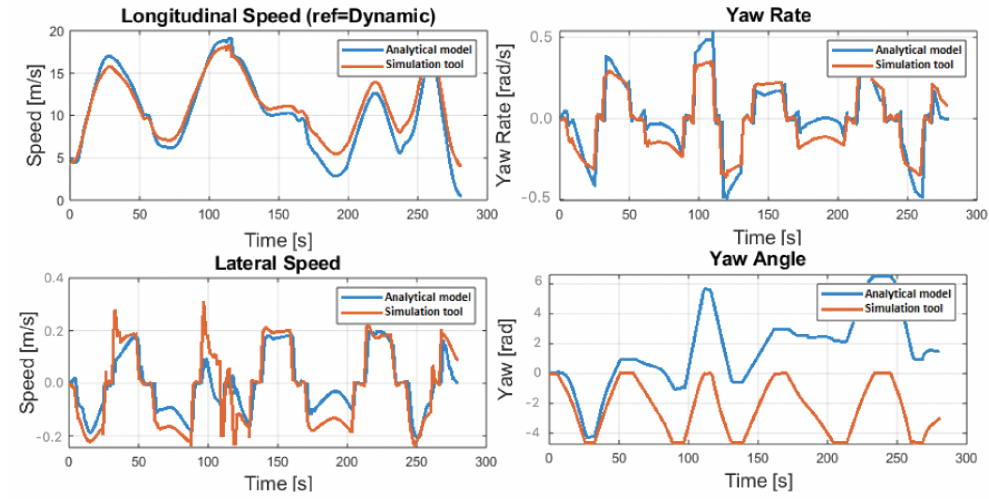
Figure 16. Dynamic speed profile results (error percentage).